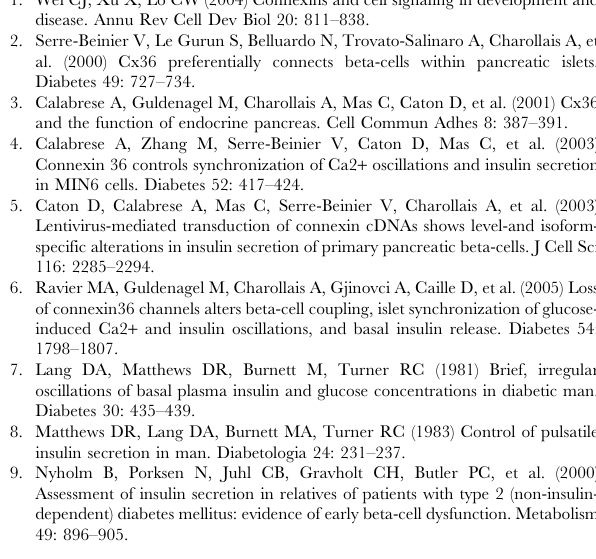
untreated and DMSO-treated cells. Data are means + SE of three independent experiments. (TIF) Figure S6 Coupling incidence of MIN6 cells, as investi- gated by tracer microinjection. ( A ) The coupling incidence (i.e. the percentage of injections showing cell-to-cell transfer of a tracer) of both Ethidium Bromide ( EB, left panel ) and Lucifer Yellow ( LY, right panel ) was markedly reduced in AS MIN6 cells when compared to WT cells. Values are means of four experiments. ( B ) The coupling incidence of both EB ( upper panel ) and LY ( lower panel ) was not markedly affected by the six drugs tested, even though a trend towards an increase and a decrease was observed in the presence of drugs increasing ( white bars ) and decreasing the synchrony index ( black bars ), respectively. (TIF) Figure S7 Schematic of the screening protocol. Flowchart of the Ca 2 + imaging screening protocol. Day 0: Plating of MIN6 cells in 96-well plate format; Day 2: Compound treatment (10 m M, 24 h); Day 3: Ca 2 + imaging; Day 4: Ca 2 + imaging analysis. (TIF) Movie S1 Glucose-induced Ca 2 + oscillations are syn- chronous in cultures of WT MIN6 cells. Video recording of one cluster of Fluo-3 loaded WT MIN6 cells during stimulation by 20 mM glucose and 15 mM TEA, revealed Ca 2 + oscillations. Within each cluster, these oscillations were synchronous between most cells. (AVI) Materials S1 Algorithms for the evaluation of intercel- lular Ca 2 + synchronization in large MIN6 cell popula-